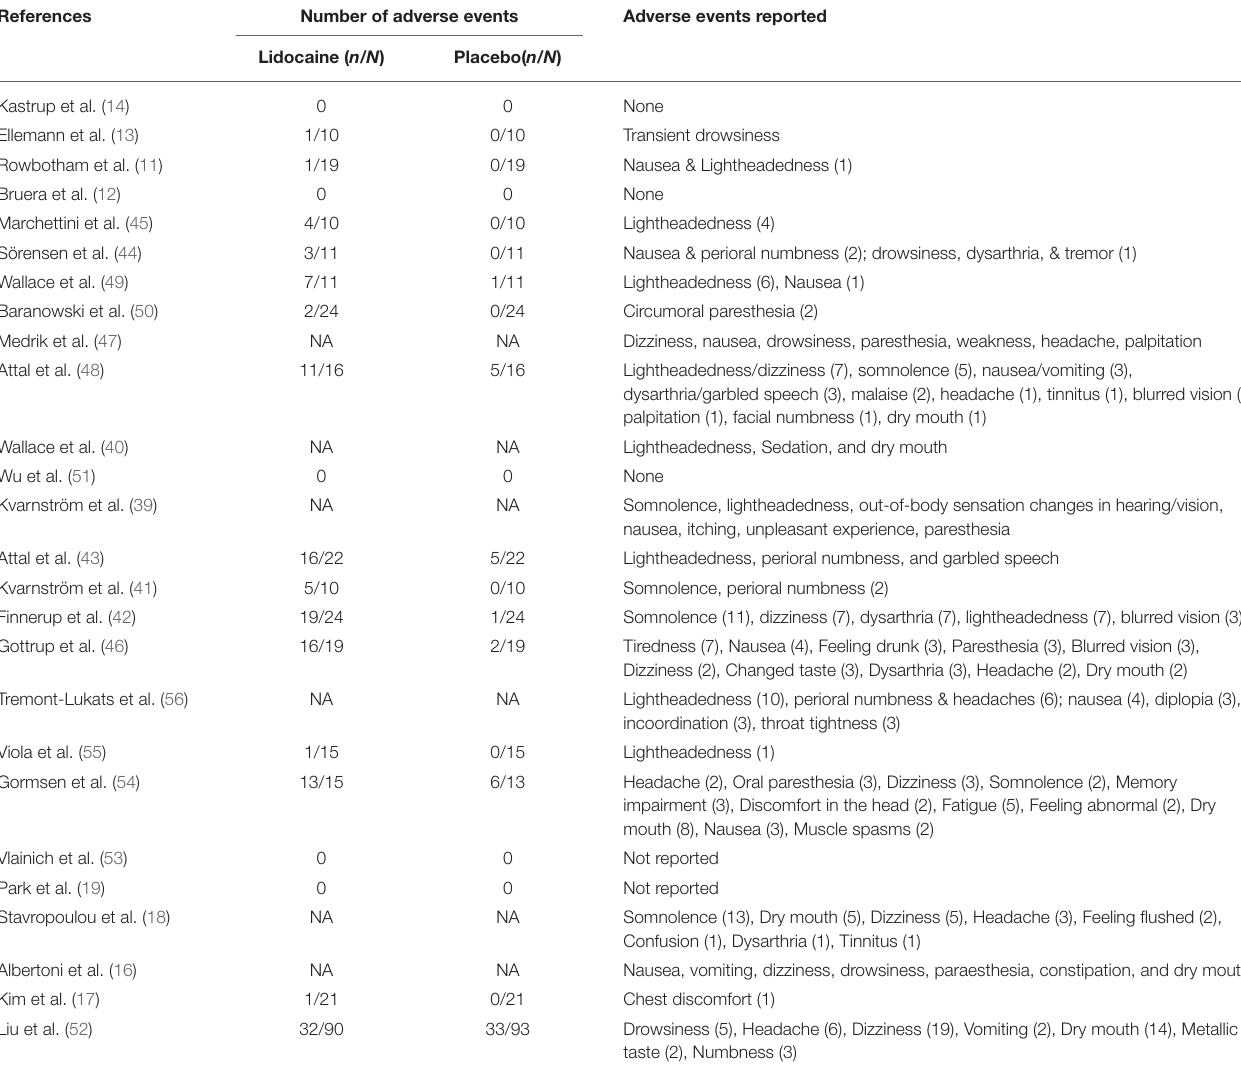
TABLE 2 | Adverse events reported in included